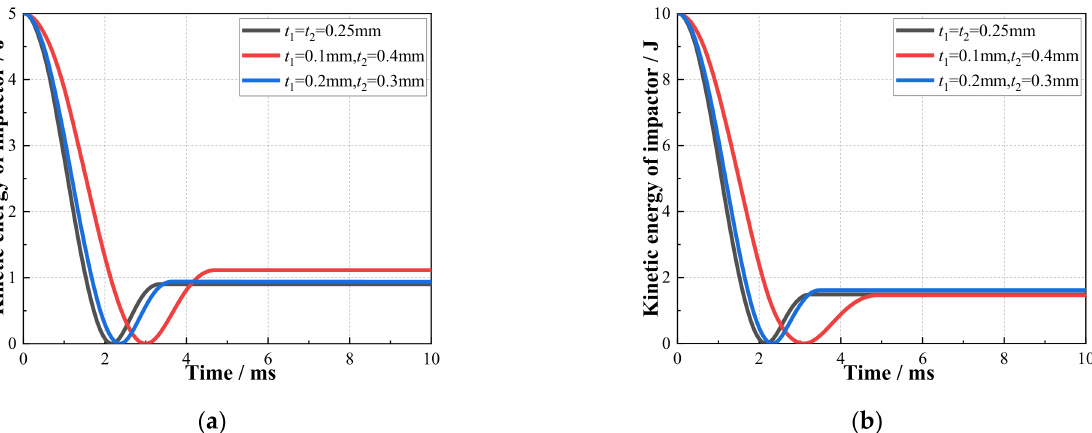
Figure 9. Kinetic energy-Time curves of impactor of double-layer structure with different core wall thicknesses under 5 J ( a ) and 10 J ( b ) impact